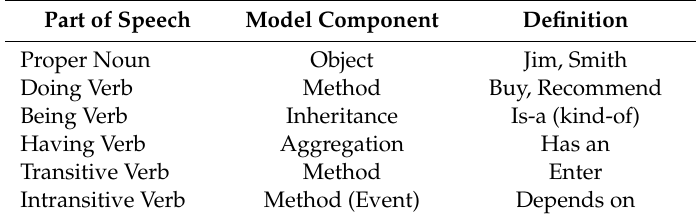
Table 4. Mapping parts of speech to object model components [18].